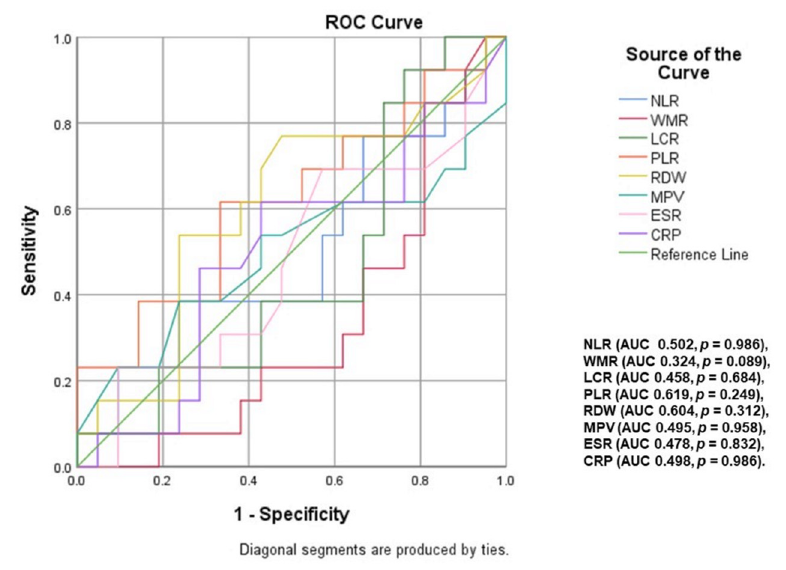
Figure 6. Inflammatory parameters with a predictive role for CPAP adherence in patients with severe OSA (NLR: neutrophil–lymphocyte ratio; WMR: white blood cell count-to-mean platelet volume ratio; LCR: lymphocyte-to-CRP ratio; ESR: erythrocyte sedimentation rate; CRP: C-reactive protein; PLR: platelet-to-lymphocyte ratio; RDW: red cell distribution width; MPV: mean platelet volume).